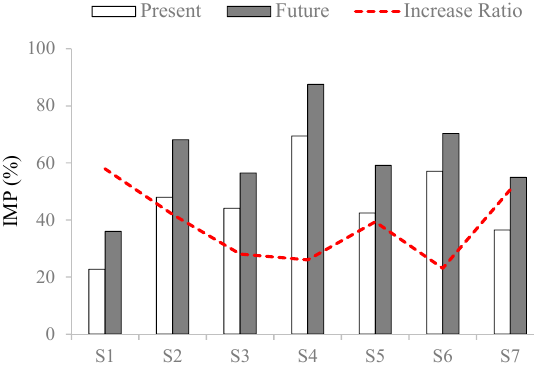
Figure 8. Comparison between present and future IMP on city scale.